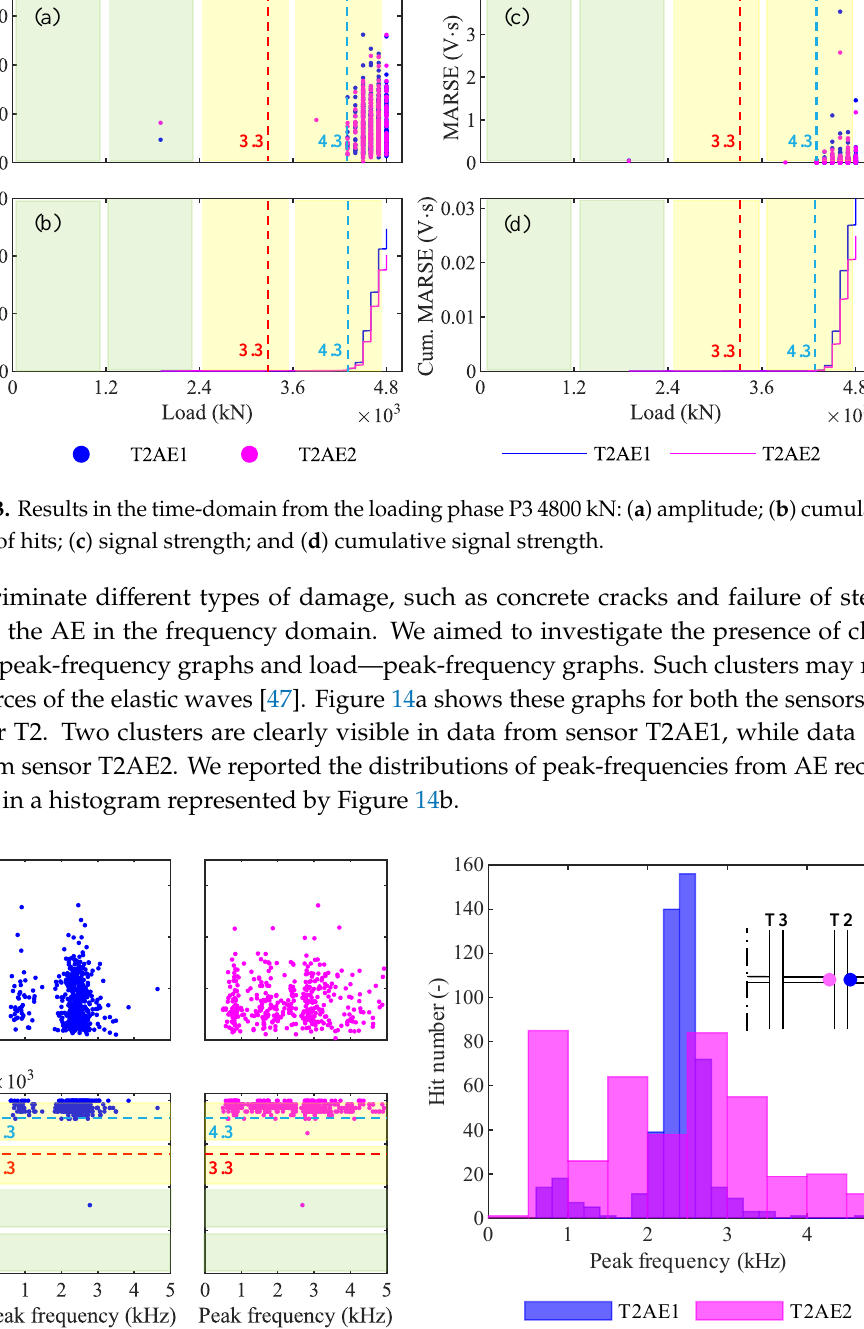
Figure 14. Results in the frequency-domain from the loading phase P3 4800 kN: ( a ) amplitude and load—peak-frequency; ( b ) peak frequency distribution among hits.